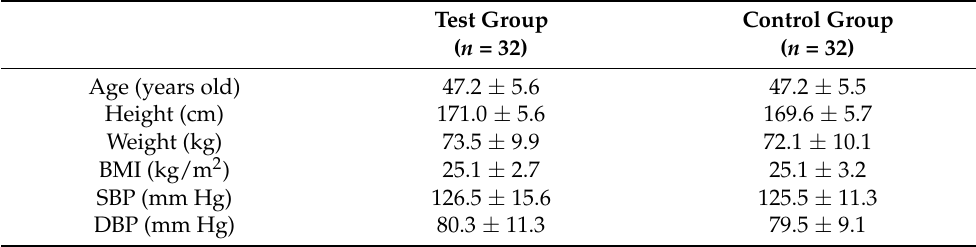
Table 1. Baseline characteristics of the study